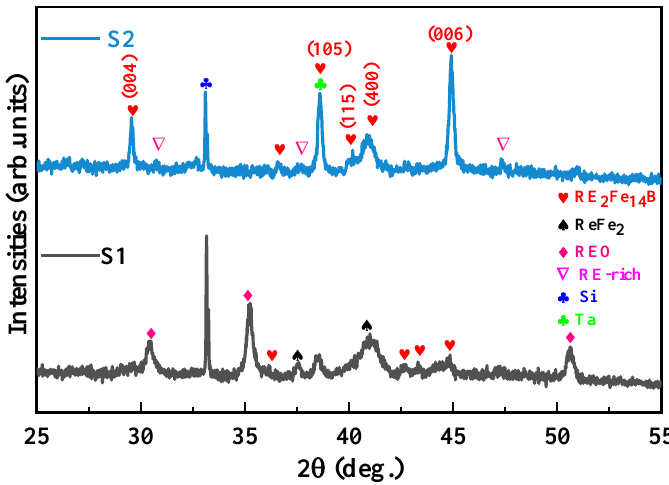
Figure 1. X-ray diffraction patterns of S1 and S2 film samples.